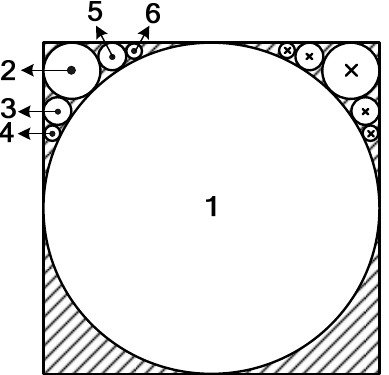
Figure 11. Configuration of the equivalent